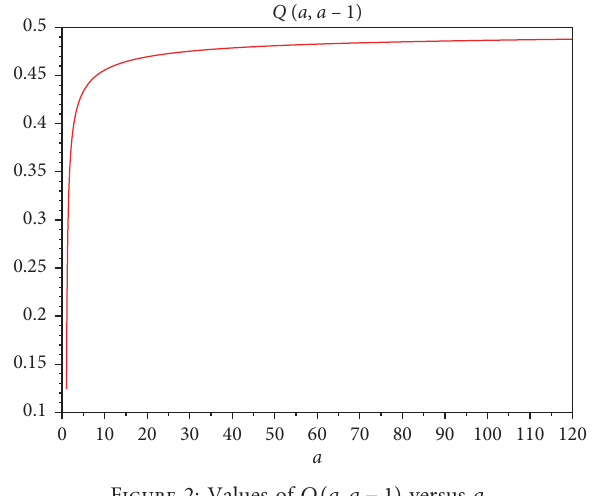
Figure 2: Values of Q ( a, a − 1 ) versus a .